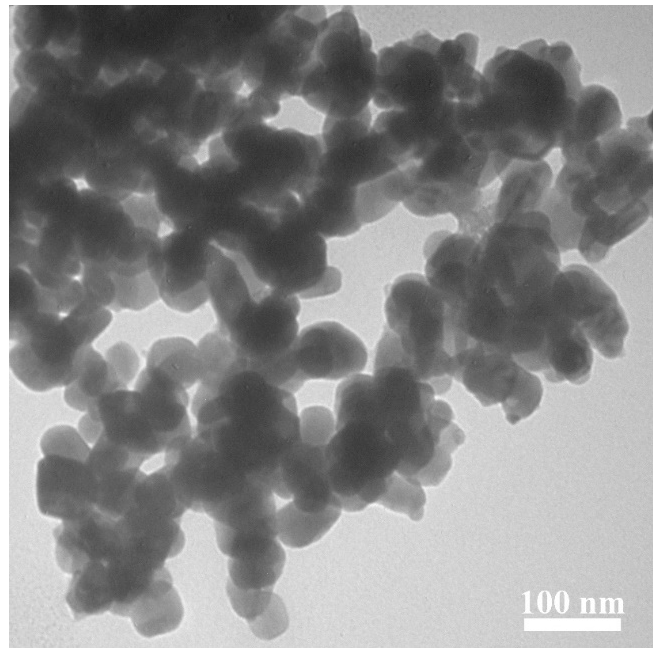
Figure 4. TEM micrograph of BaSO 4 nanoparticles.